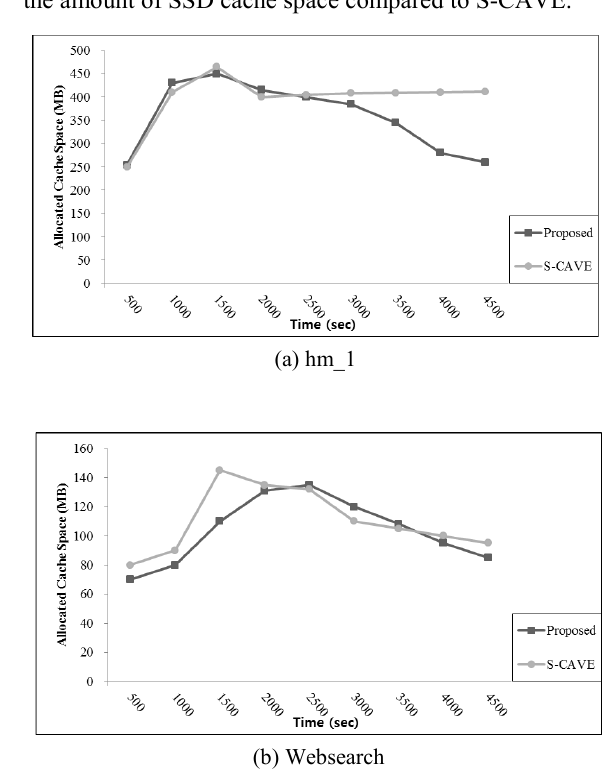
Fig. 7. The comparison of cache space allocated to each VM.